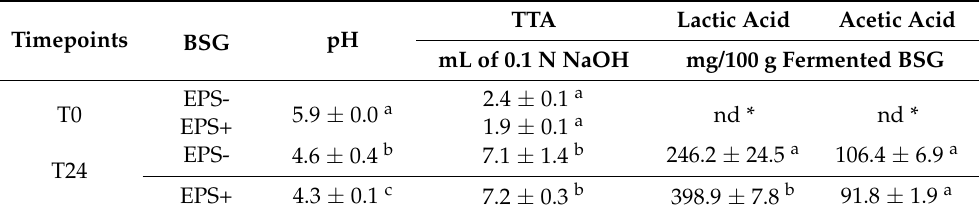
a–c Values with different letters in the same column are significantly different (Tukey’s test. p < 0.05). * nd: not detected.